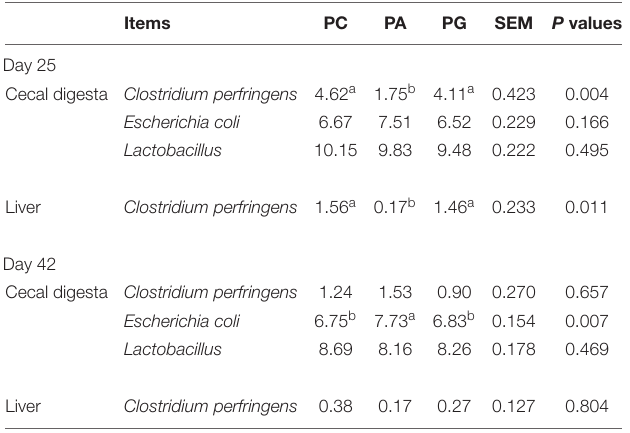
TABLE 6 | Effects of B. licheniformis and enramycin on tight junction protein and mucin-2 gene expression in jejunum of broilers challenged with SNE. Items